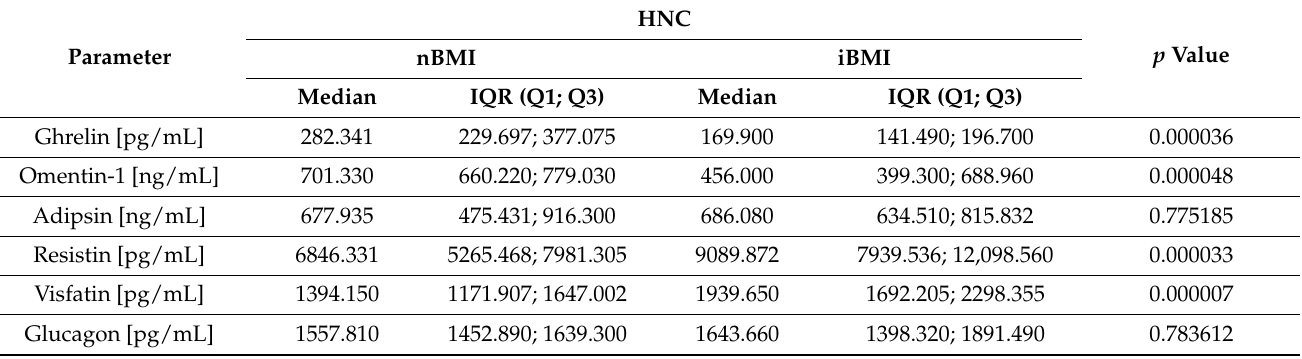
Table 3. Biochemical parameters with a statistically non-parametric distribution analyzed in head and neck cancer (HNC) patients with respect to their body mass index